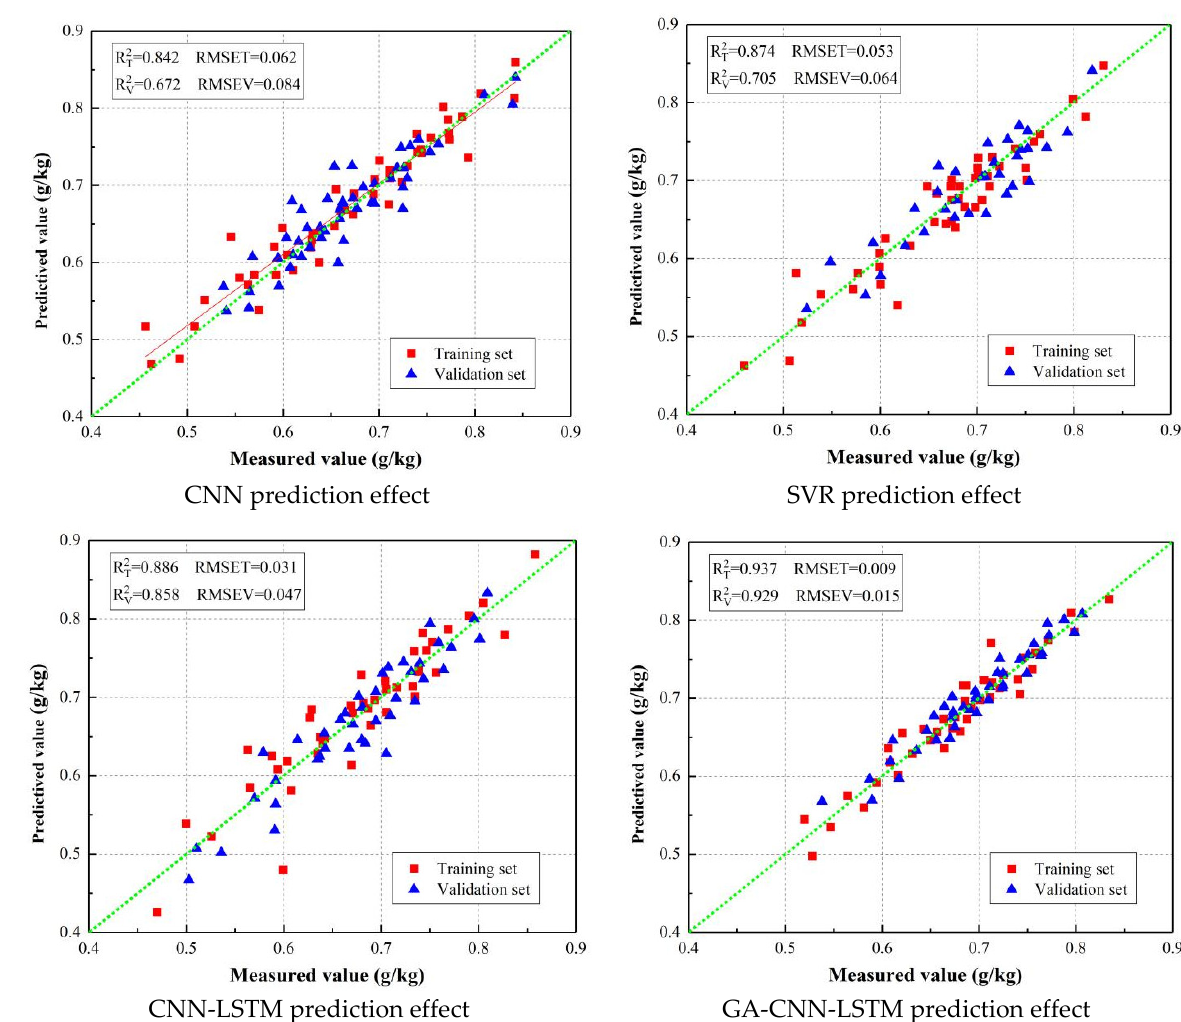
Figure 7. Measured and predicted values of SN content.